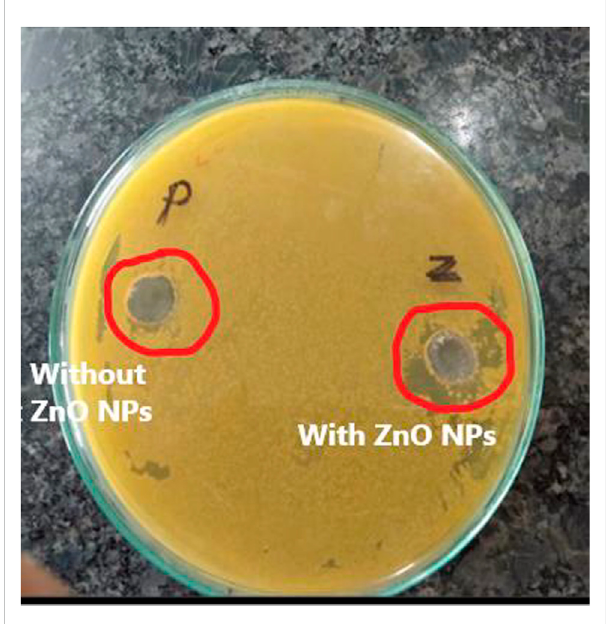
FIGURE 7 The antibacterial activity of ZnO NPs on Escherichia coli .